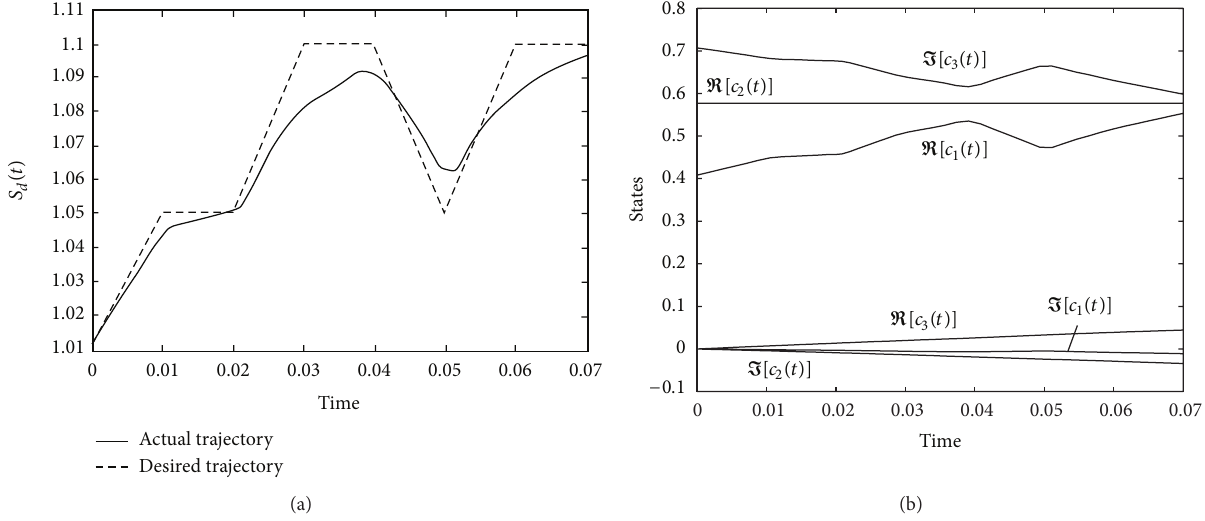
Figure 7: Evolutions of the entropy and states for system (72) under controller